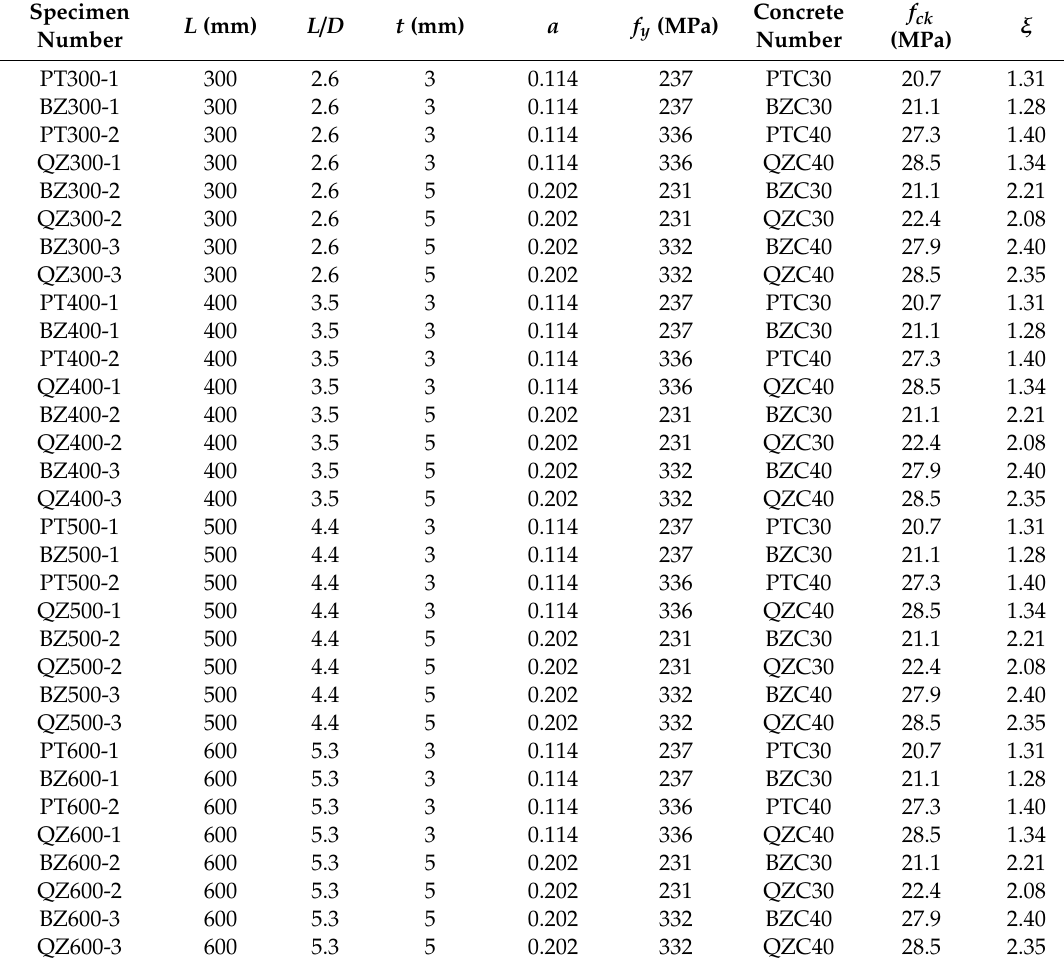
Table 1. Parameters of the specimens.